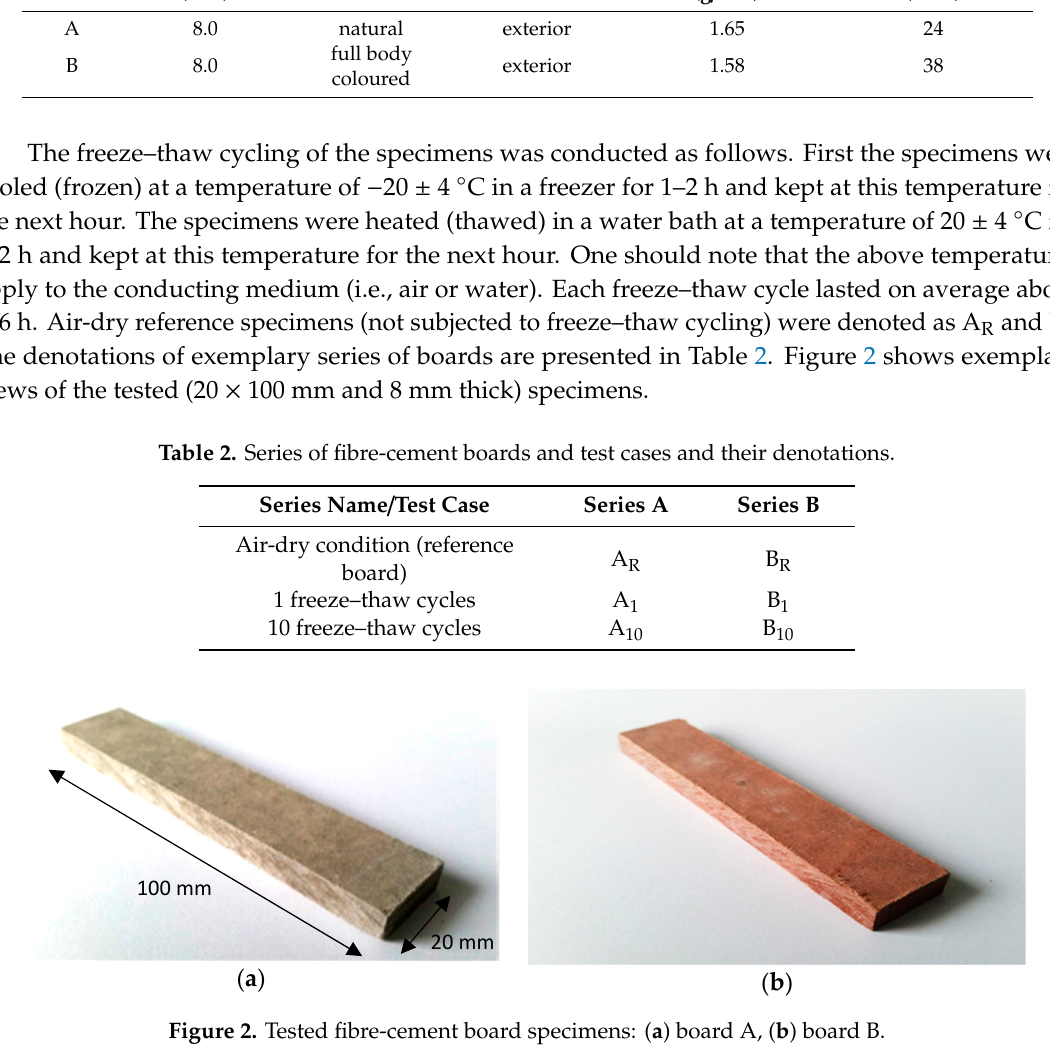
Figure 2. Tested fibre-cement board specimens: ( a ) board A, ( b ) board B.